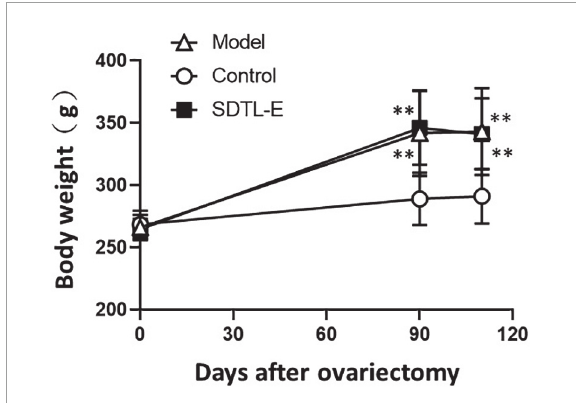
FIGURE1 Changes of body weight of rats. 90 days after ovariectomy, Model Group ( n = 12) and Control Group ( n = 12) rats were treated with vegetable oil. SDTL-E Group ( n = 10) rats were treated with SDTL-E. All treatments were topically applied twice daily for 20 days. Rats were weighed before ovariectomy, 90 days after ovariectomy (treatment day 1) and 110 days after ovariectomy (treatment day 20). Values are mean ± SD . ∗∗ p < 0.01 vs. Control Group.